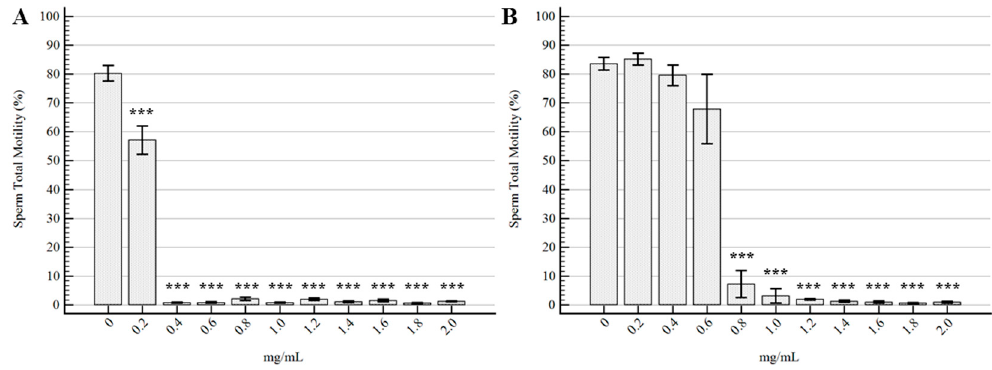
Figure 2. Effects of the EOs on total motility . ( A ) Thymbra capitata . ( B ) Rosmarinus officinalis . Data are expressed as the mean ± standard error of the mean ( n = 6), and 0 mg/mL represents the control sample (only emulsifiers). *** = p < 0.001.